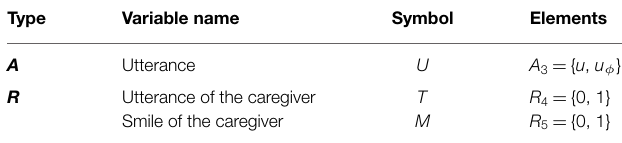
TABLE 2 | Additional variables for the experiment